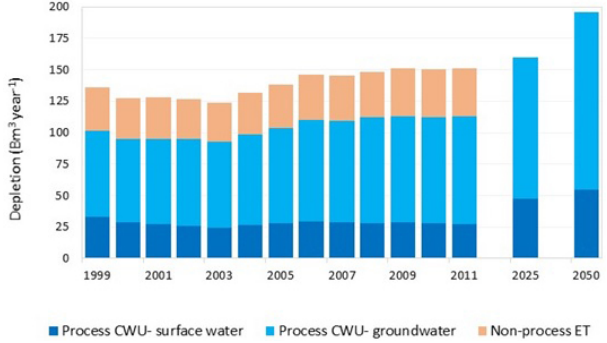
Figure 4. Water use in the Ganges River basin – past trends and pro- jections. Source: trends (1999–2011) are the authors’ estimates. The CWU projections are based on Amarasinghe et al. (2007, 2014).